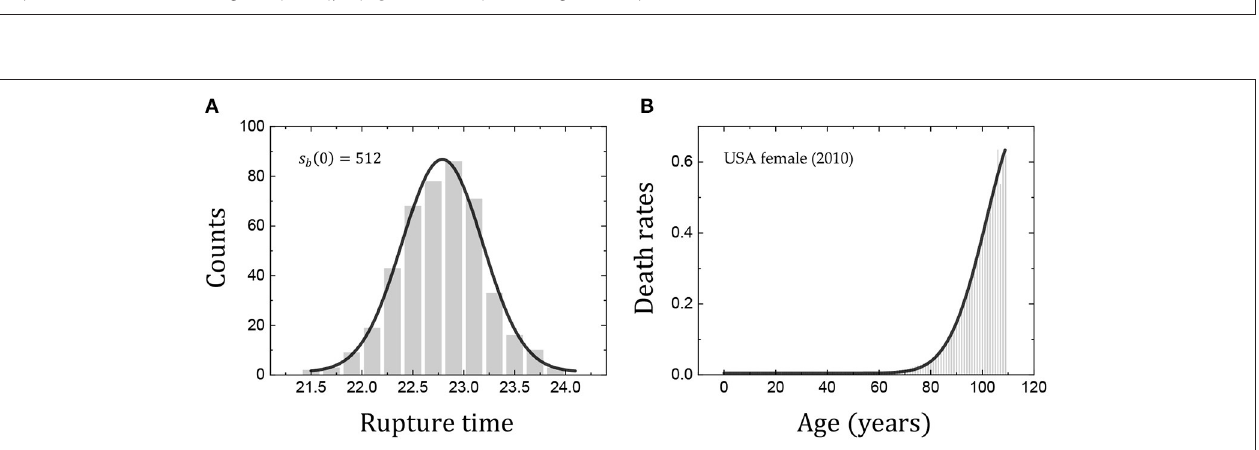
FIGURE 5 | Comparison with experimental results in foams. (A) The Boltzmann sigmoidal function for the experimental data [[40, 41] for coarsening foams and [42] for coalescing foams, see details on data collection and analysis in the Supplementary Note ] is rescaled as η = ( s − a 2 ) / ( a 1 − a 2 ) = 1 / [1 − e ( x − x 0 ) /ω ]. The collapse of all data indicates the validity of the Boltzmann sigmoidal function. (B) The mortality rates µ decrease exponentially at the positive ( x − x 0 ) /ω , equivalent with the exponential increase at the negative ( x − x 0 ) /ω ( Figures 2D , 3B ), indicating the Gompertz law.